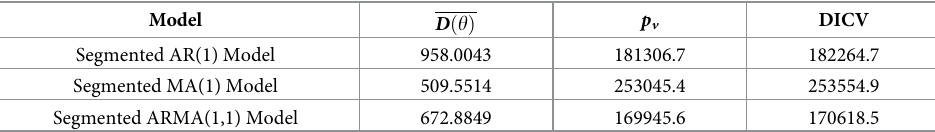
Table 1. DICV of